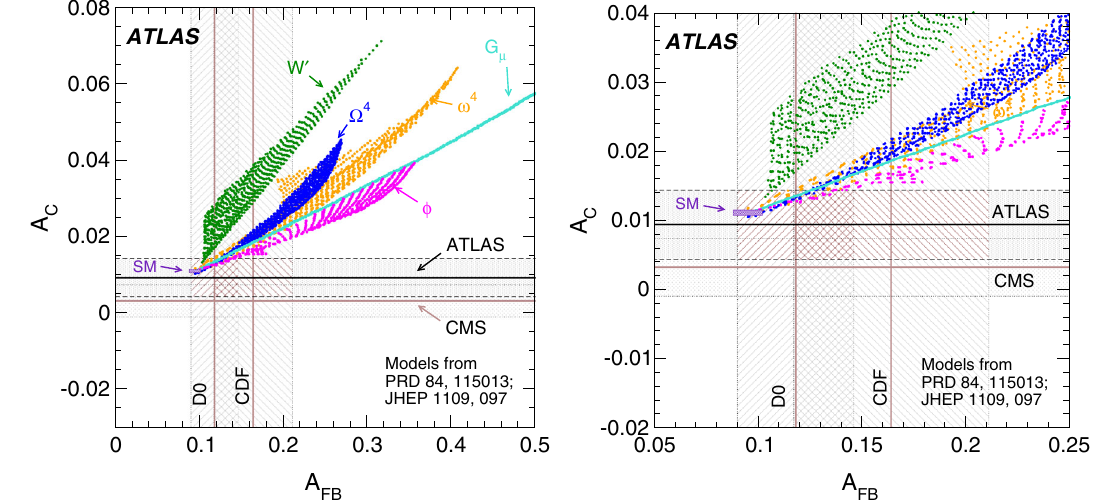
Fig. 4 Measured inclusive charge asymmetries A C at the LHC ver- sus forward–backward asymmetries A FB at Tevatron, compared with the SM predictions [1,2] as well as predictions incorporating various potential BSM contributions [3,4]: a W (cid:2) boson, a heavy axigluon ( G μ ), a scalar isodoublet ( φ ), a colour-triplet scalar ( ω 4 ), and a colour-sextet